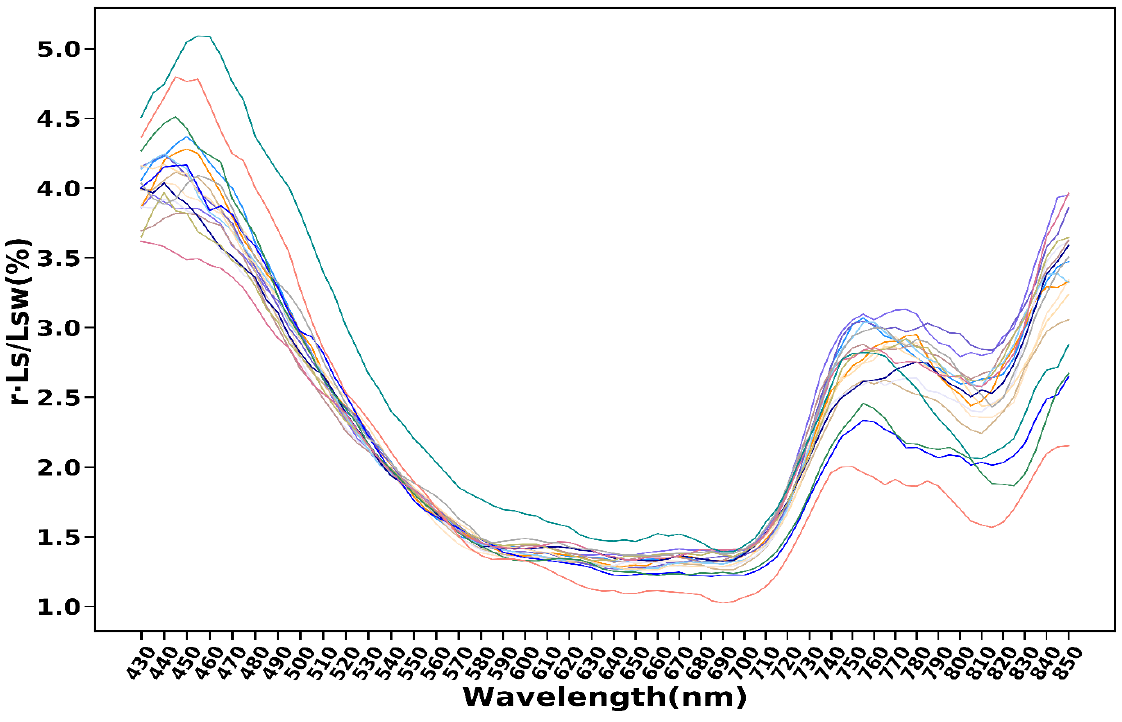
Figure 6. The proportion of the product of sky light radiance ( 𝐿 𝑠 ) and a coefficient ( r = 0.022) in the upwelling radiance ( 𝐿 𝑠𝑤 ). The lines with different colors represent 18 different experimental results.